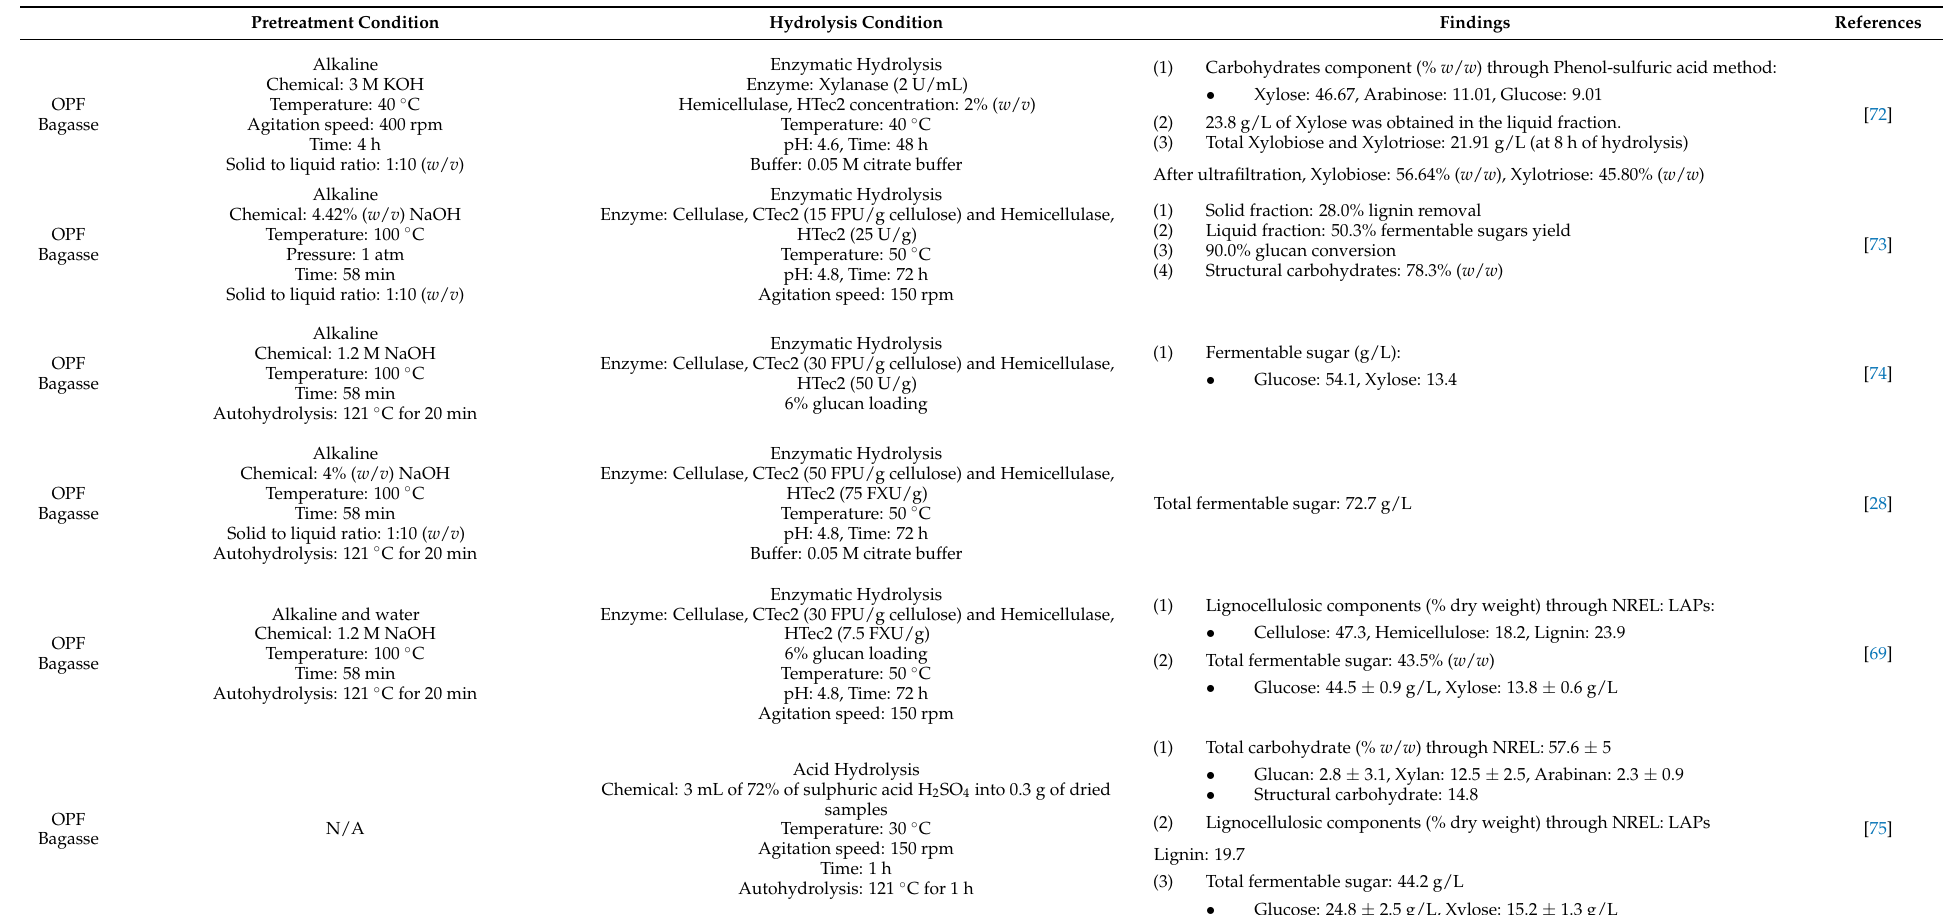
Table 2. The pretreatment and hydrolysis process conducted to the oil palm